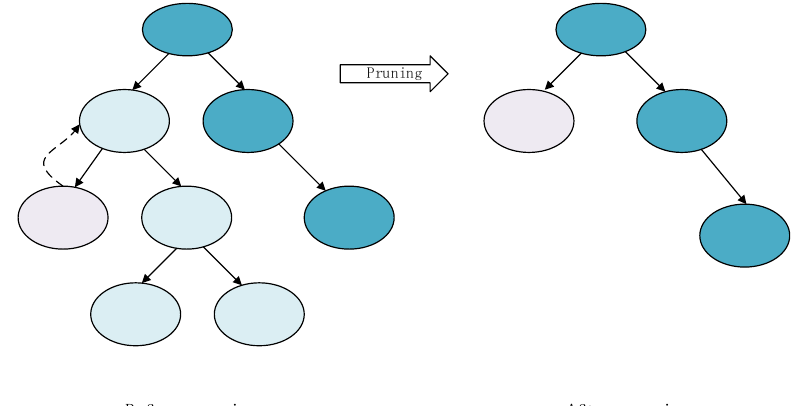
Figure 4. Decision tree